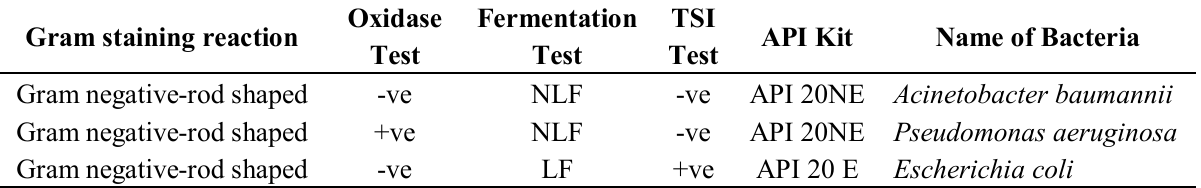
Table 4. Detection of Gram negative bacteria from re-growing bacteria in sterilized waste. Gram staining reaction